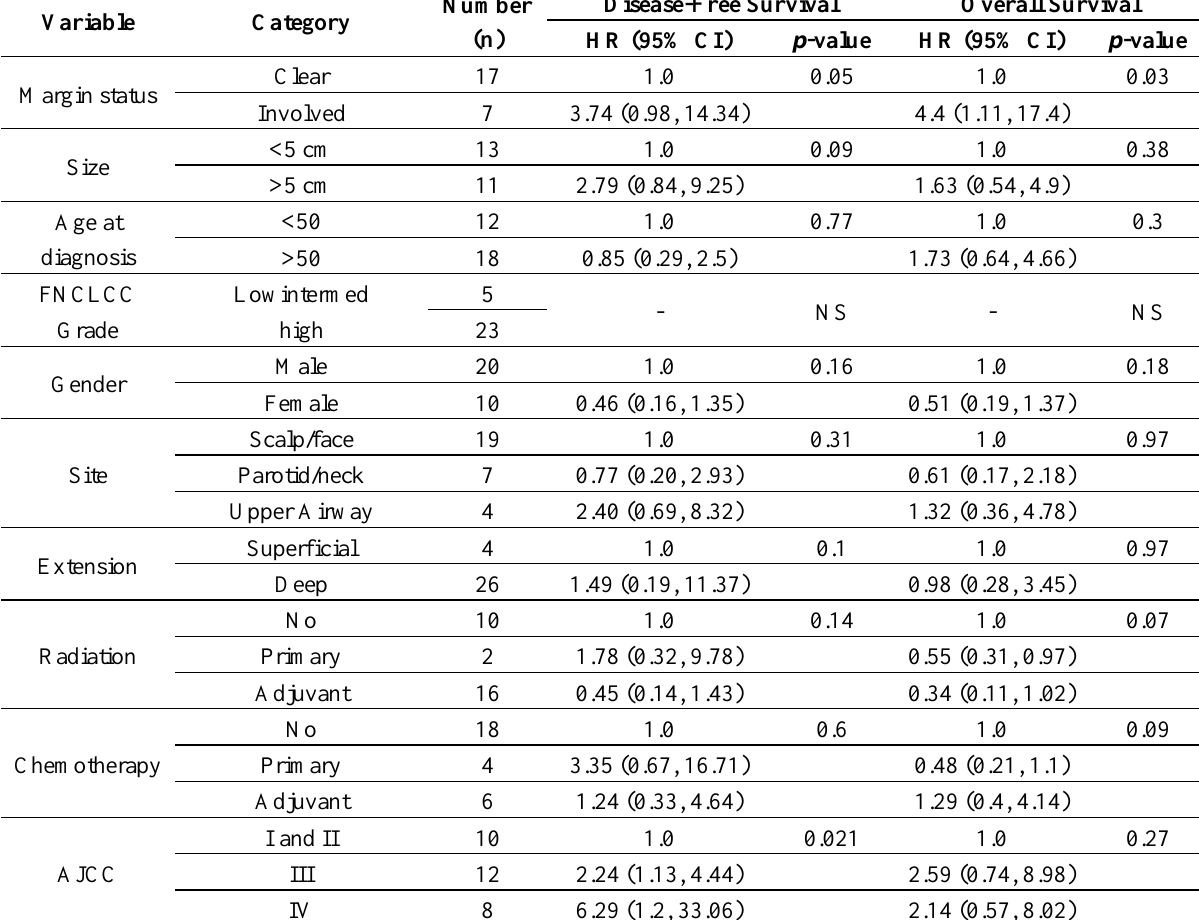
Table 3. Univariate analysis of factors Associated WITH DFS and OS in soft tissue sarcomas.